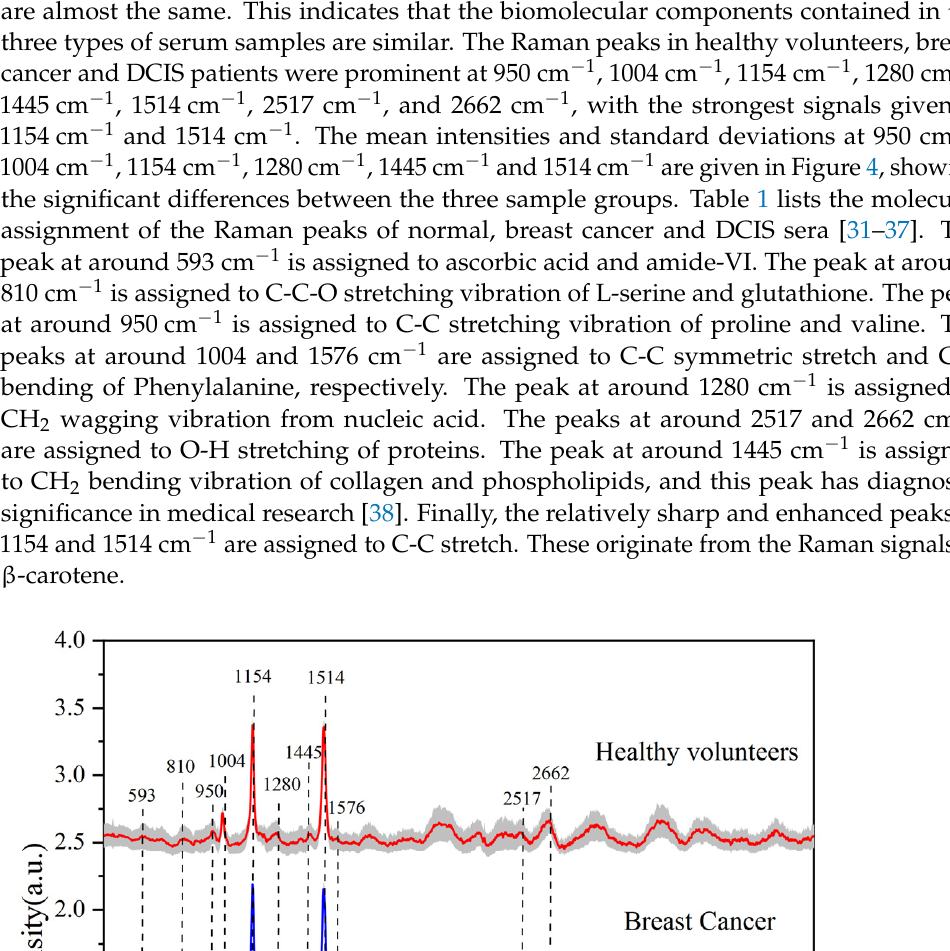
Figure 4. Mean intensities and standard deviations of the main Raman peaks. Table 1. The assignments of Raman peak in the serum spectra. Peaks